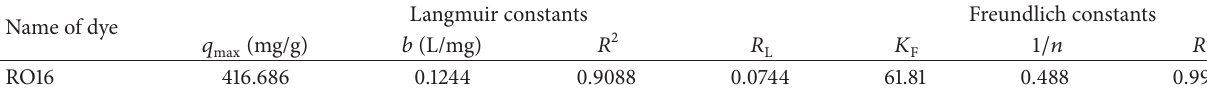
Table 3: Langmuir and Freundlich constants for adsorption of RO16 on MKCF.